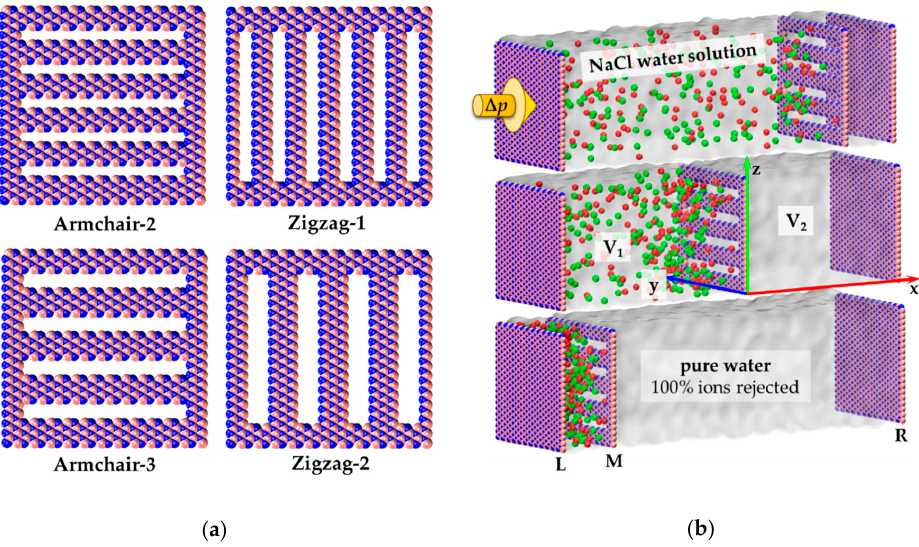
Figure 1. Models of nanoporous membranes and the simulation setup: ( a ) Armchair and zigzag design of nanopores in h-BN nanosheet; ( b ) Simulation domain comprises two volumes—the feeder filled with NaCl water solution (left) and the outlet reservoir (right). The model contains three h-BN nanosheets L, M, and R. The middle one (M) is a nanoporous membrane, and its coordinates are fixed. Plane of